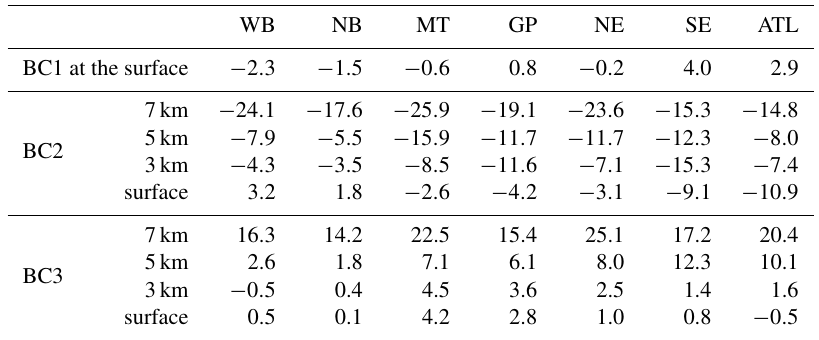
Figure 10. Differences in the seasonal averaged DM8A BCT (in ppb, a ) and DM8A BC2 / BCT (in percentage, b ) between COSMO-CLM / CMAQ and WRF / CMAQ (COSMO-CLM / CMAQ minus WRF / CMAQ) in the analysis domain. The areas in white or grey are the grid cells that are out of the simulation domain of either of the two models. Table 6. Seasonally averaged differences between COSMO-CLM / CMAQ and WRF / CMAQ (COSMO-CLM / CMAQ minus WRF / CMAQ) in BC1 (ppb) at the surface, in BC2 (ppb) and BC3 (ppb) at the surface, and at a specific elevation (above ground level) in summer at 14:00LST over seven subregions. WB NB MT